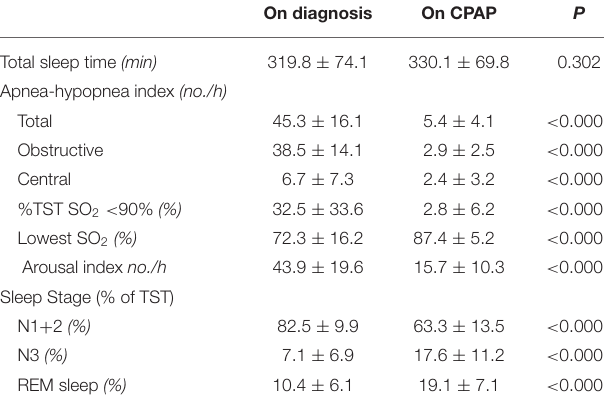
sleep quality, which were expressed as sleep stages, percentage of slow-wave sleep, and rapid eye movement (REM) sleep. The CPAP therapy decreased AHI, as well as the arousal index